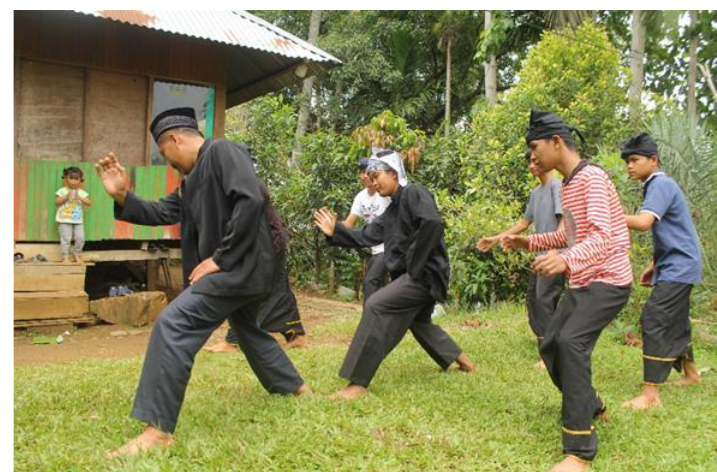
Fig. 1 Baraja Malangkah , (Ediwar et al., 2022).